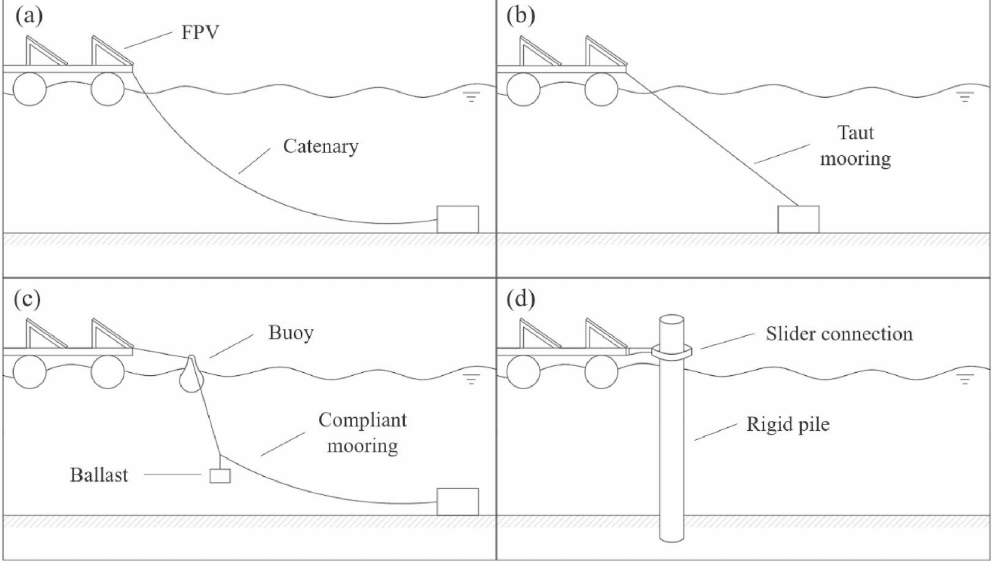
Figure 4. Mooring layouts: catenary ( a ), taut ( b ), compliant ( c ) and rigid ( d ) mooring, adapted from